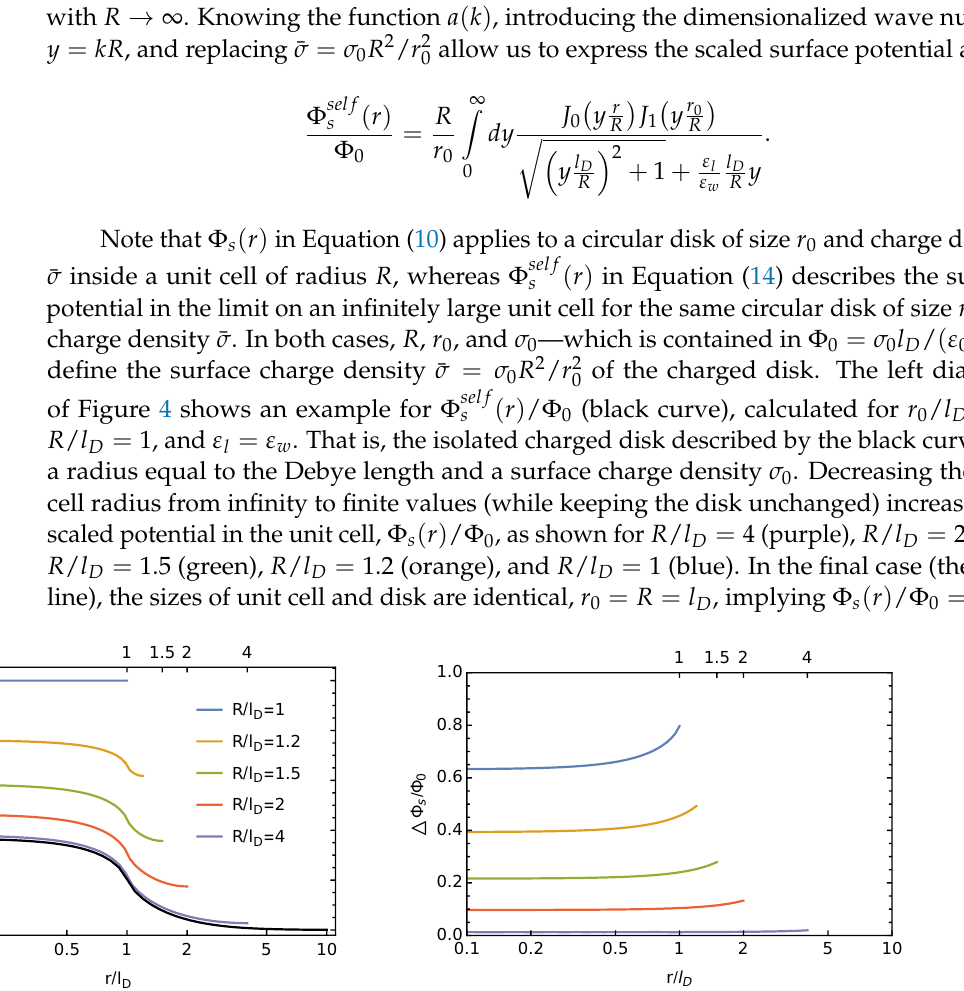
Figure 4. Left diagram: The scaled potential Φ s ( r ) / Φ 0 for a charged disk of radius r 0 / l D = 1 and surface charge density σ 0 that resides in a unit cell of radius R / l D = 1 (blue curve), R / l D = 1.2 (orange), R / l D = 1.5 (green), R / l D = 2 (red), R / l D = 4 (purple), and R / l D → ∞ (black). The black curve is calculated using Φ self s ( r ) / Φ 0 in Equation (14), and all others are based on Φ s ( r ) / Φ 0 in Equation (9), with ε l = ε w in each case. Right diagram: The difference (cid:52) Φ s ( r ) / Φ 0 between each colored curve and the black curve on the left diagram. The legend on the left diagram also applies to the right diagram. Note that (cid:52) Φ s ( r ) = Φ s ( r ) − Φ self s ( r ) corresponds to the surface potential in the unit cell produced by all charged disks other than that in the considered unit